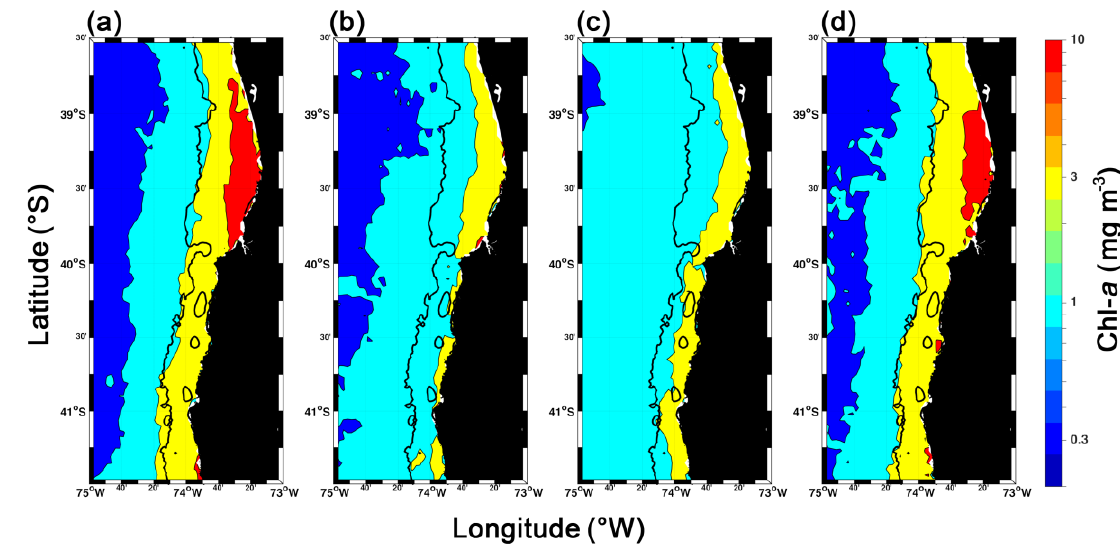
Figure 8. Long-term average of Chl-a (color, mg m − 3 ): austral summer ( a ), autumn ( b ), winter ( c ), and spring ( d ). The boundary of the continental shelf is indicated with the a 200 m isobath (black line) and was obtained from ETOPO2v2